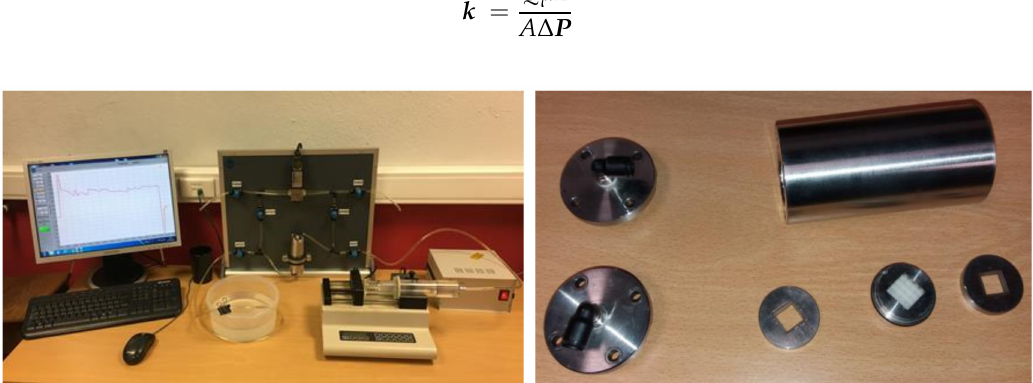
Figure 2. Experimental apparatus for the permeability tests (left: overview; right: permeability chamber